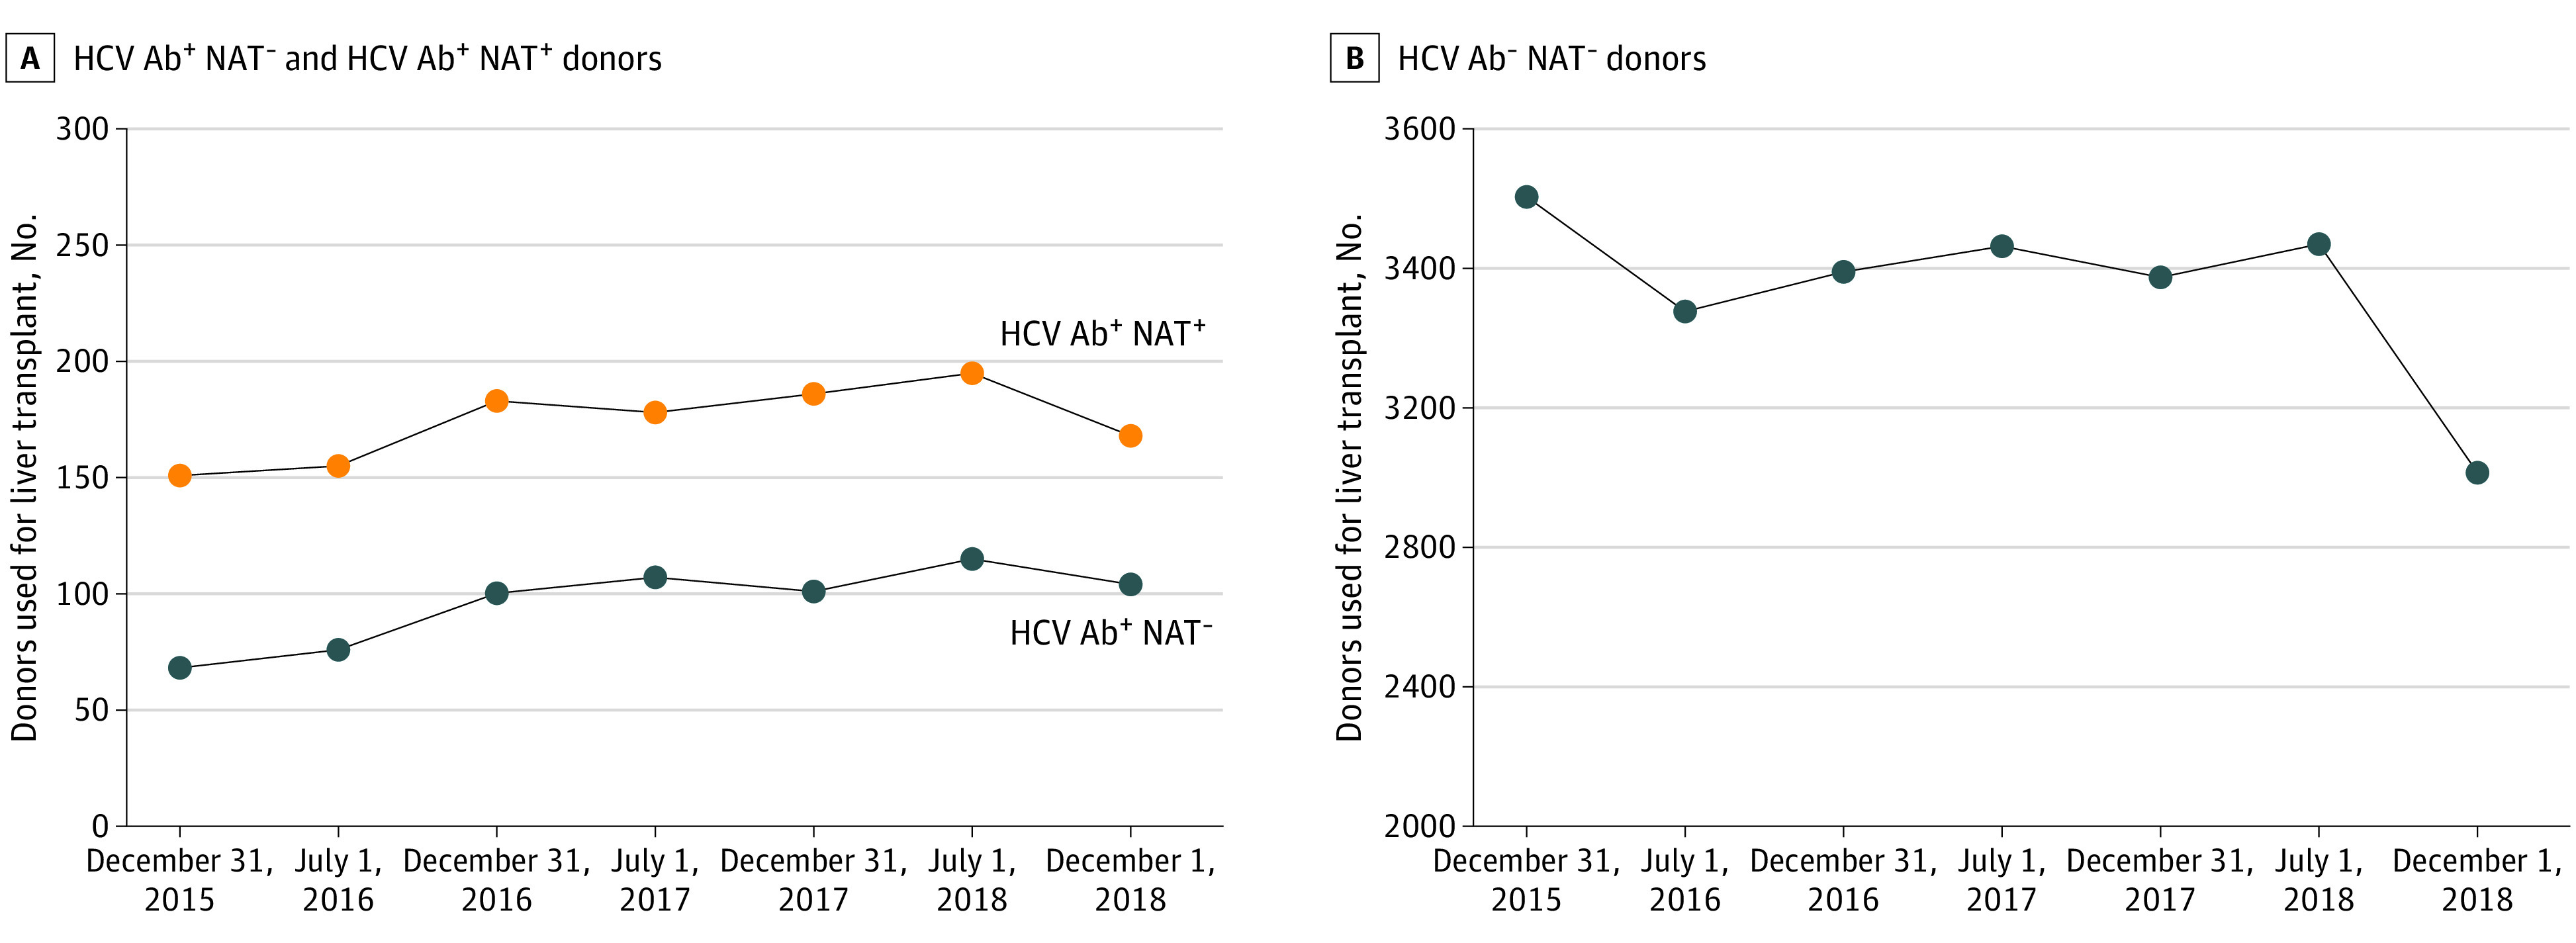
The Trend of the Number of HCV Ab+ NAT− and HCV Ab+ NAT+ Donors and the Trend of the Number of HCV Ab− NAT− DonorsA, This panel shows the trend of the volume of HCV Ab+ NAT− and HCV Ab+ NAT+ donors utilized in the preceding 6 months from June 1, 2015 to December 1, 2018. Data from December 2018 was unavailable and not included. B, This panel shows the trend of the volume of HCV Ab− NAT− donors utilized in the preceding 6 months from June 1, 2015 to December 1, 2018. Data from December 2018 was unavailable and not included. Superscript plus sign indicates positive for HCV; superscript minus sign, negative for HCV; Ab, antibody; HCV, hepatitis C virus; NAT, nucleic acid amplification testing.